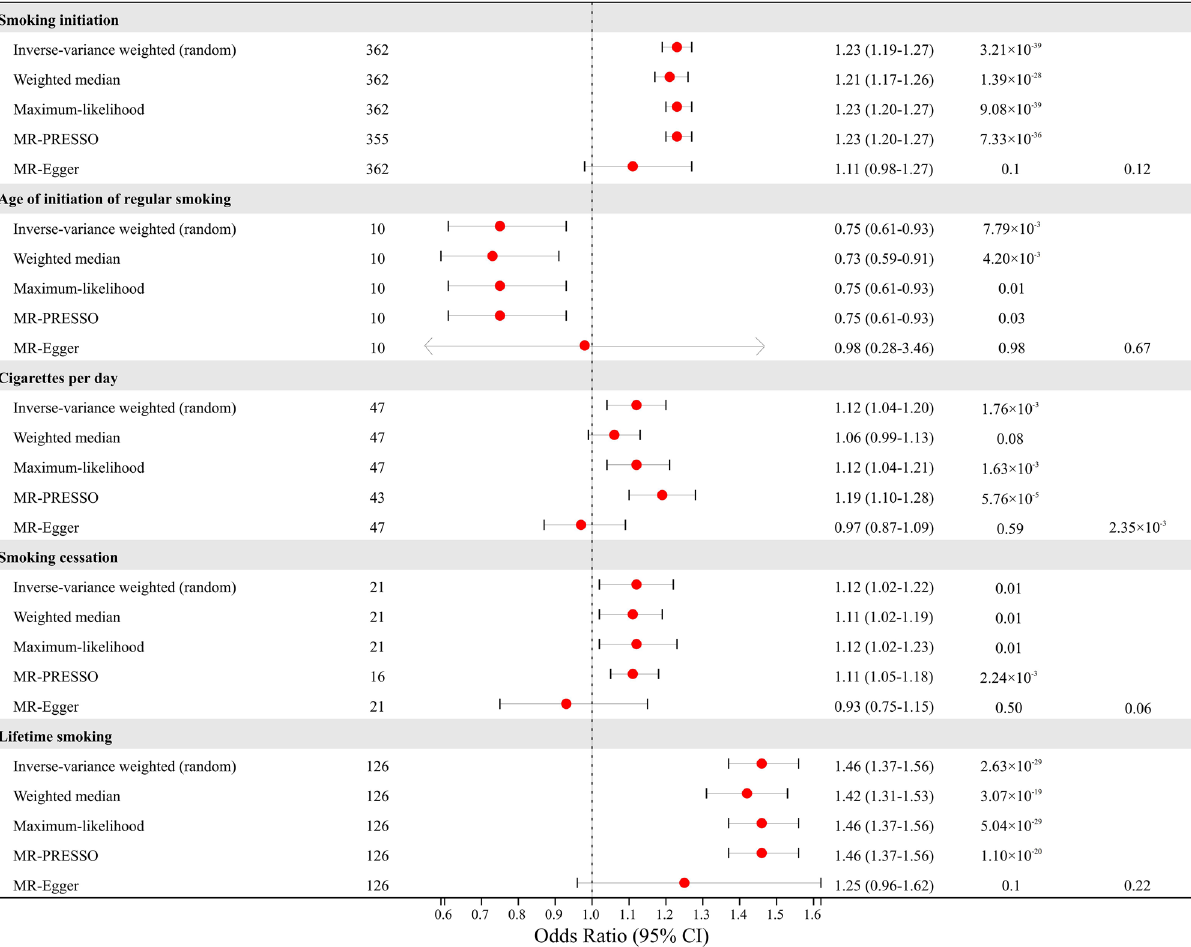
Figure 2. Forest plot of MR analysis of five smoking phenotypes with risk of frailty in